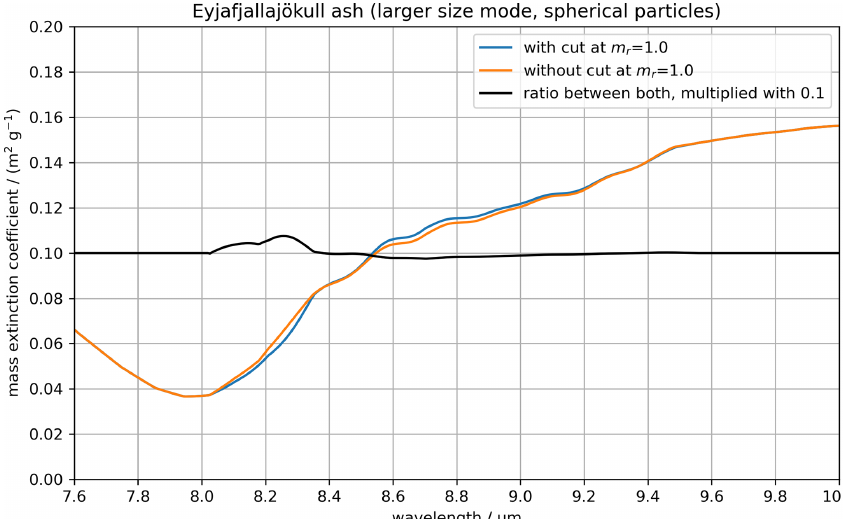
Figure B3. Mass extinction coefficients for spherical particles with the original refractive index m from Fig. B2 (orange line) and with the same refractive index m r cut at 1 in the spectral region between 8 and 10µm (blue line). The black line is the ratio between the orange and blue line and has been multiplied by 0.1, meaning that a value of 0.1 corresponds to exactly the same values in the two situations.